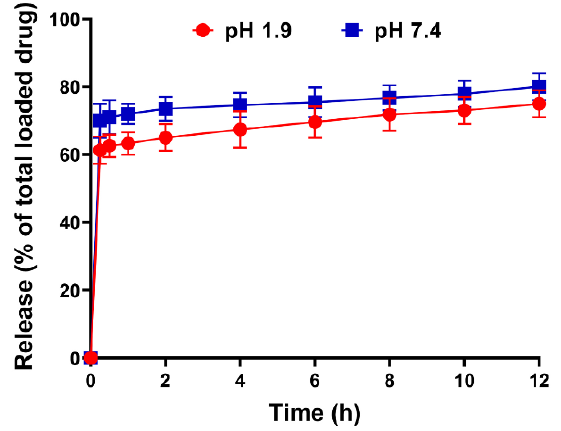
Figure 4: The cumulative percentage of albend- azole (ABZ) release versus time from ABZ-loaded Mobil Composition of Matter No. 41 (MCM-41) NPs at pH 1.9 and 7.4. As the results showed, a burst drug release from the NPs occurred at the first 15 min of the study, leading to the release of 62 and 70 % of the loaded drug at pH 1.9 and 7.2, respectively. The release was then continued with a sustained and controlled release in the remain- ing time of the study. Statistical analyses were performed using one-way analysis of variance (ANOVA) and F-tests. The data are expressed as mean ± SD (n =